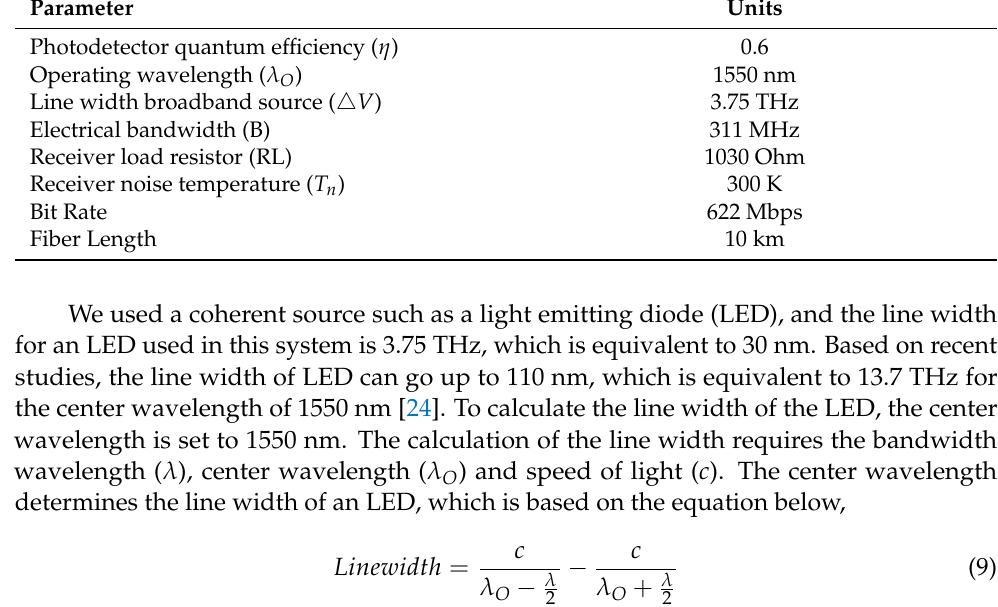
Table 7. Typical parameters used in the calculation. Parameter Units Photodetector quantum efficiency ( η ) 0.6 Operating wavelength ( λ O ) 1550 nm Line width broadband source ( (cid:52) V ) Electrical bandwidth